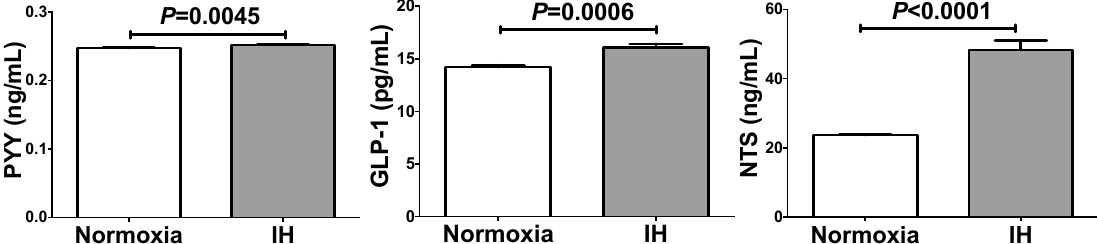
Figure 2. The concentrations of PYY, GLP-1, and NTS in the Caco-2 cell culture medium. IH significantly increased PYY (102 ± 0.368%), GLP-1 (113 ± 2.36%), and NTS (203 ± 11.5%) concentrations in the culture medium. The living cell numbers of normoxia treated cells and IH treated cells are similar levels because the mRNA levels of house keeping genes in IH treated cells were similar to those in normoxia treated cells (91.12 ± 4.196%, p = 0.1484). The measurable ranges were 0.15–10 ng/mL for PYY, 3.91–250 pg/mL for GLP-1, and 0.1–1000 ng/mL for NTS. We measured the concentrations of the peptides directly without any concentrations and dilutions. As the values were within the measurable ranges, the concentrations in the medium are comparable with those in human plasma. Data are expressed as mean±SE for each group ( n = 6). The statistical analyses were performed using Student’s t -test.